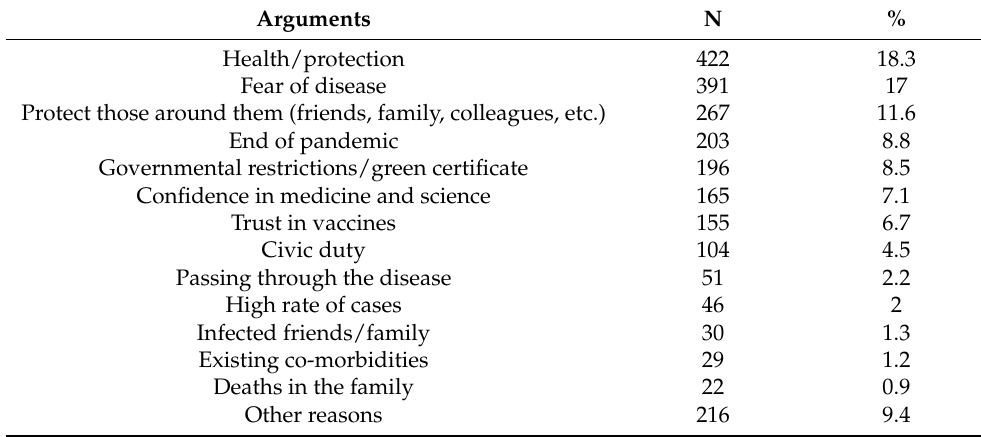
Table 7. Participants’ arguments underlying the decision to vaccinate against